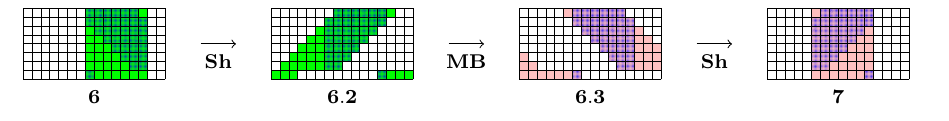
Figure 8: Fitting the two pieces, first